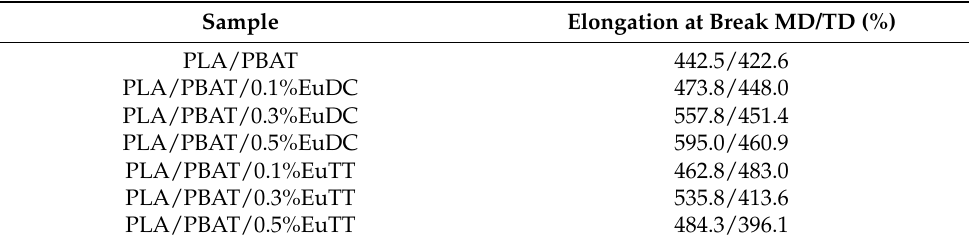
Table 3. Mechanical properties of PLA/PBAT, PLA/PBAT/EuDC, and PLA/PBAT/EuTT films. Adapted with permission from ref. [29]. Copyright 2019 Science